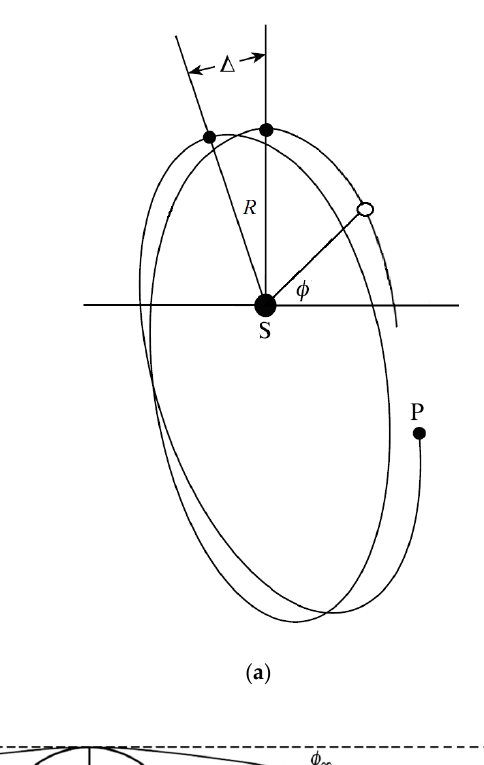
combined with the weak Einstein’s Equivalence Principle (EEP) (1) and SR provides a method for calculating the precession of Mercury’s perihelion due to Sun gravity (Figure